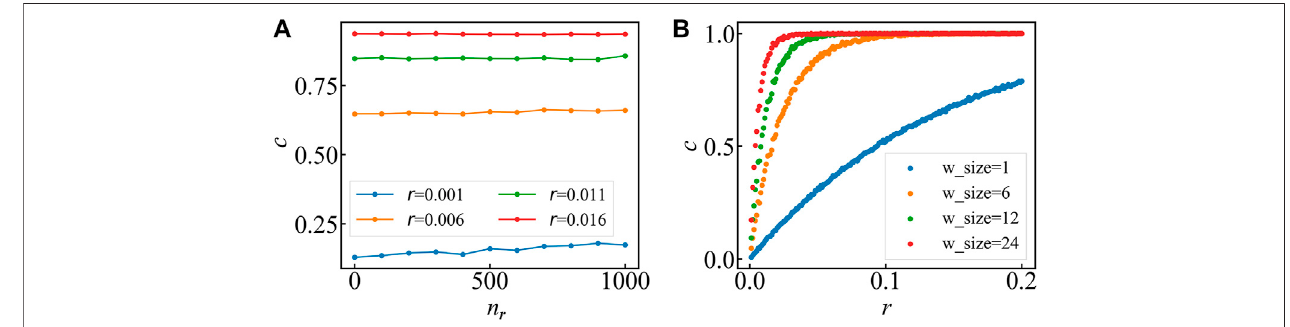
FIGURE1|(A) Averagesimilarityscoresatdifferentcorrelationlevel.ThesequencesofdeviceAandBaregenerated10times.Theresultsshowedinthis fi gureare theaverageof10experiments whenthewindow sizeis24.Similarity scorebarely changesas n r increases. Thelinemovesupwards when actualcorrelation r increases. (B) Average similarity scoresat differentwindow size. Theresults are also the average of10experiments but when adding 1,000 random alarm timestampsinto S B . The range that probability score varies with r widens as the window size decreases.